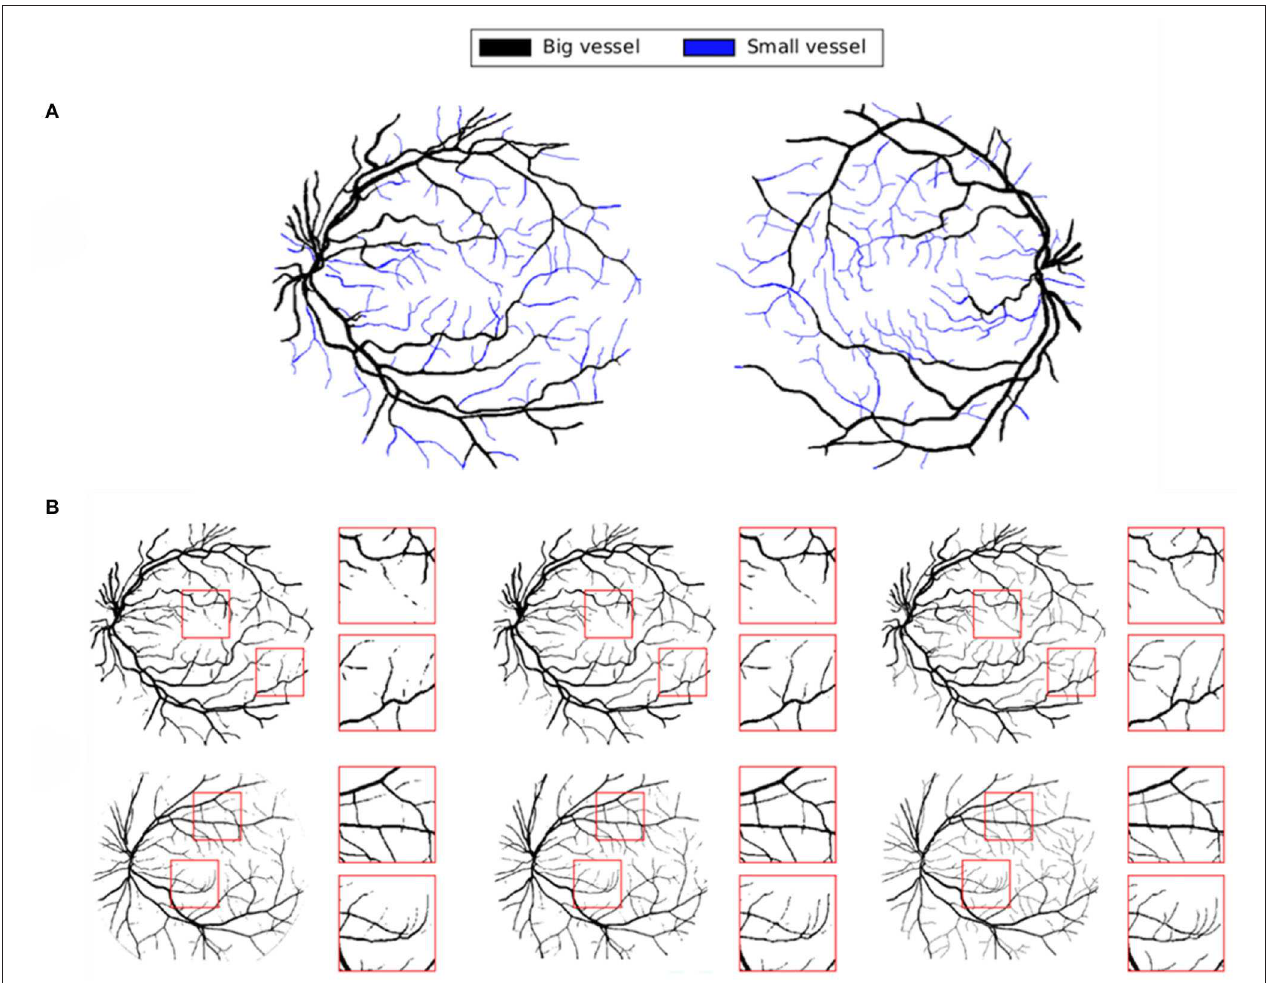
FIGURE 11 | (A) Classification of small and big vessels in FA images. (B) Segmentation results of baseline SegCaps on FA images. Boxes are used to illustrate the capturing of finer detail (small vessels) produced by our